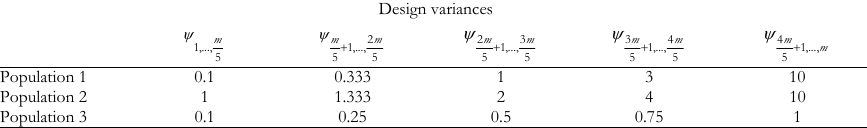
Different configurations of design variances for the simulation Design